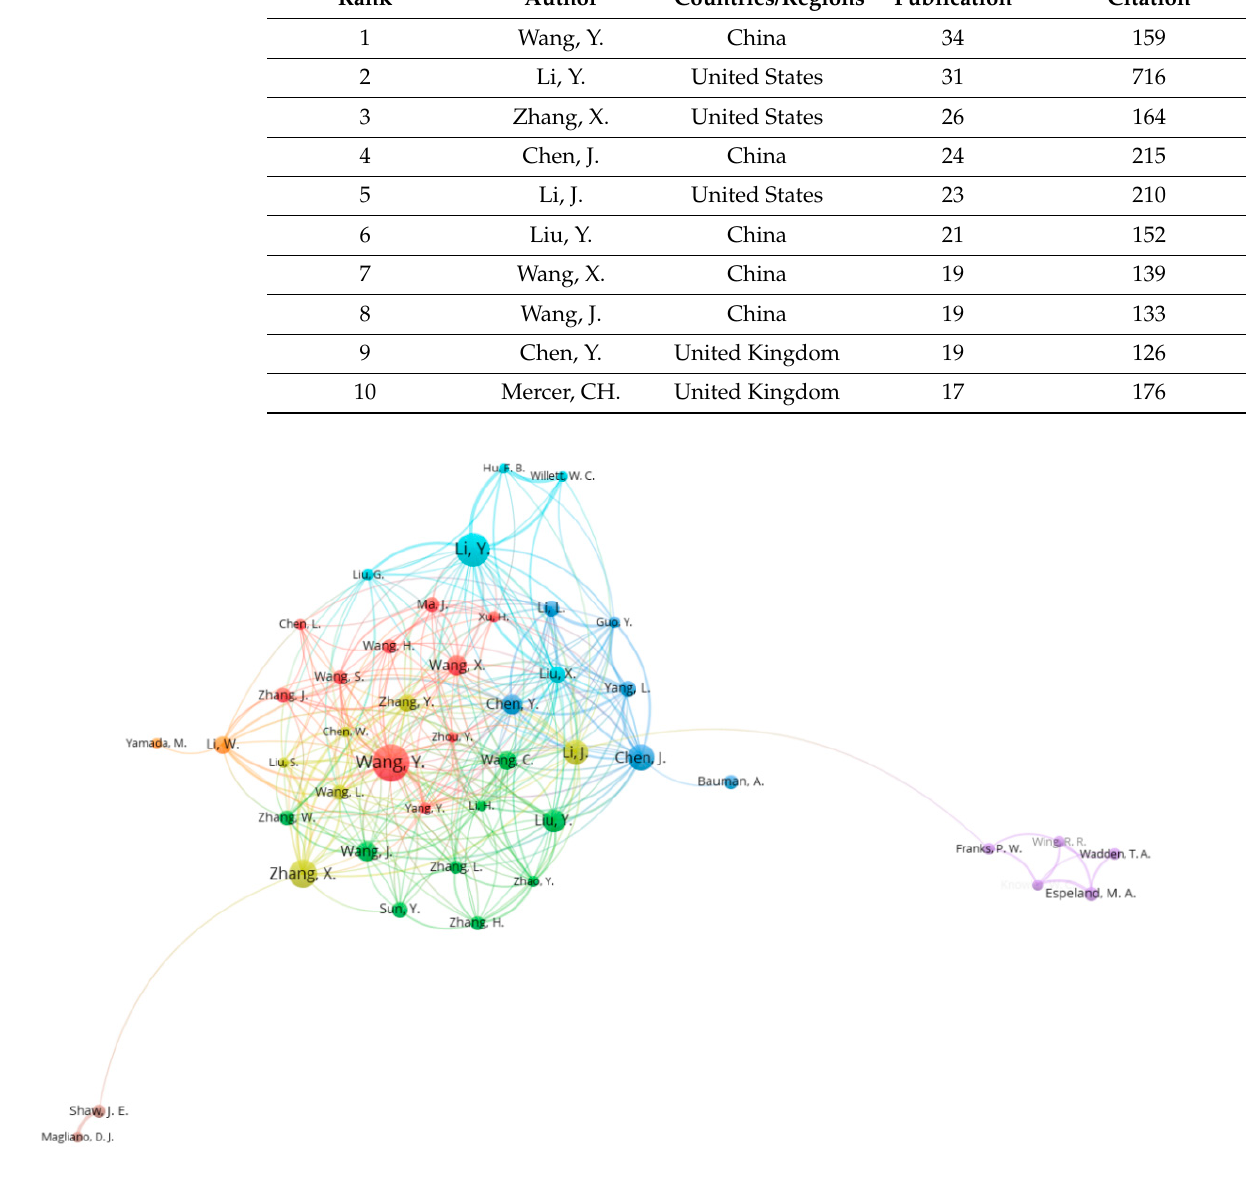
Figure 3. Distribution and co-authorship of authors.